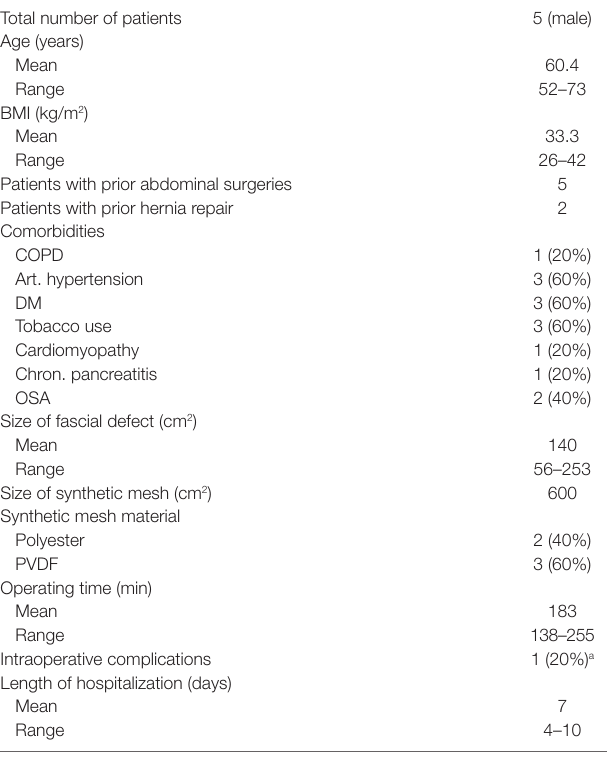
tABLe 2 | Patient with endoscopic anterior component separation, direct laparoscopic closure of the linea alba, and following